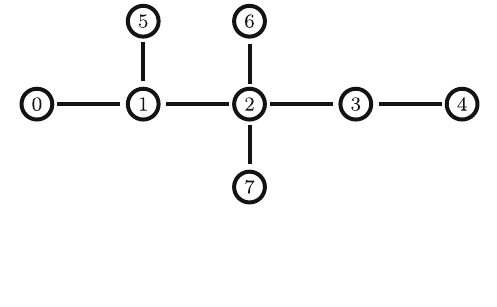
Figure 1: The path P